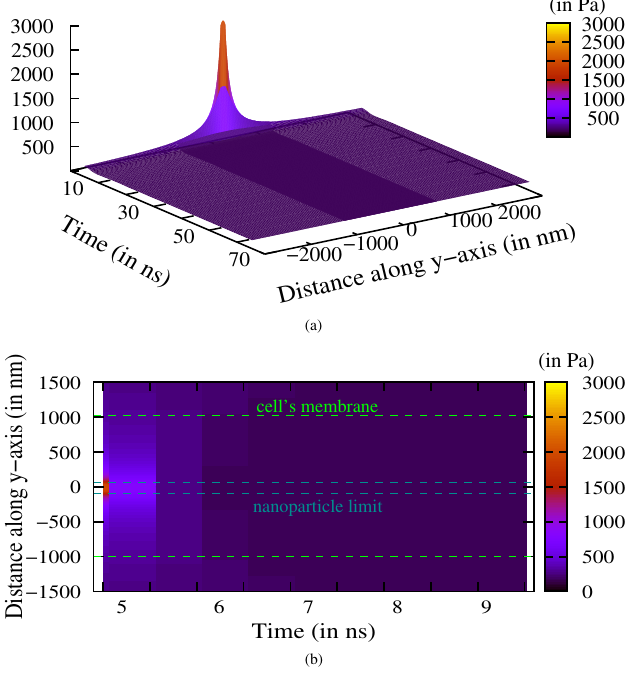
Figure 4. ( a ) Time evolution of the variation of the pressure (in Pa) in the cell (i.e., | y | ≤ 1000 nm) and in the water (i.e., | y | ≥ 1000 nm); ( b ) The spatial distribution of the pressure variation is computed from the center of the nanoparticle (i.e., at | y | ≈ 0 nm) and propagated to the cell membrane (i.e., at | y | ≈ 1 µ